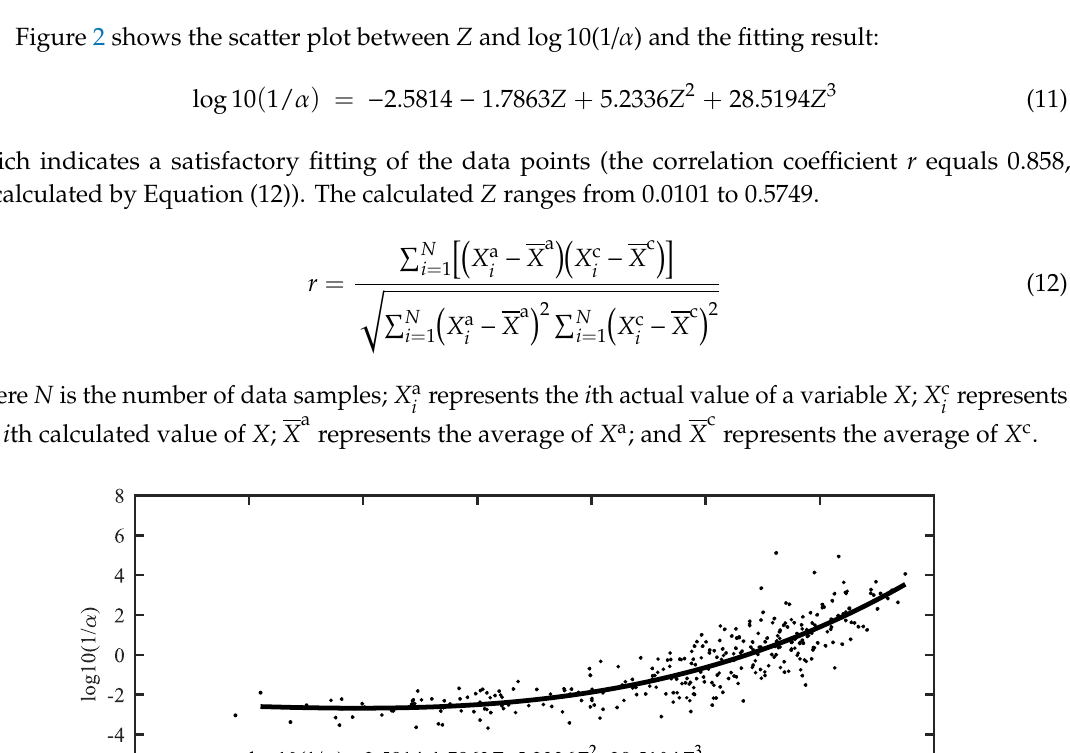
Figure 2. Scatter plot between log10(1/ α ) and Z = κ 0.48 ( δ m / D 50 ) 0.13 log10( V / V c ), and the fitting result.